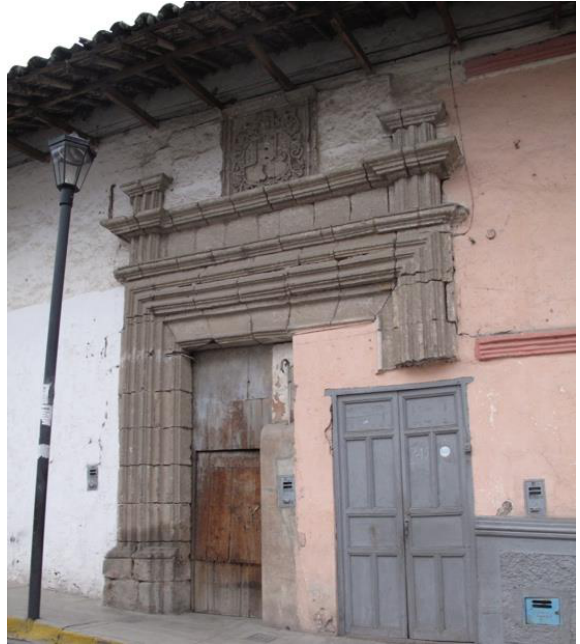
Figure 5. Inappropriate